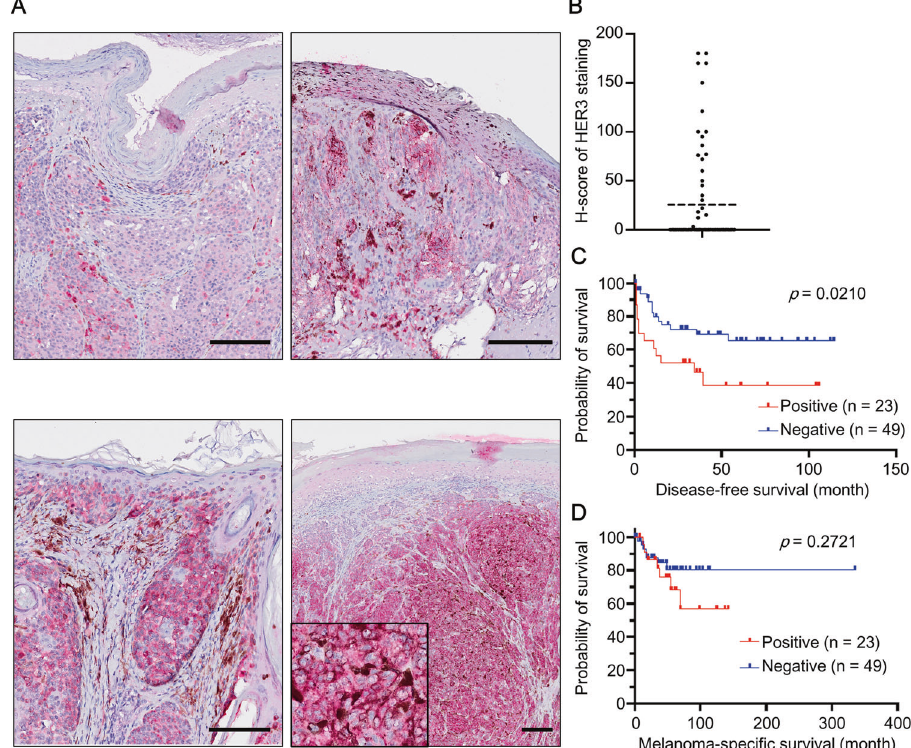
Fig. 1 HER3 expression and relevance of HER3 intensity to the survival of AM patients. A AM tissues from 72 AM patients were immunohistochemically stained for HER3. Representative images are shown. Scale bars = 200 μ m. B HER3 expression in clinical AM tissues was quanti fi ed using a semi-quantitative method and is shown as H-score. The H-score was obtained by multiplying the staining intensity (range 0 – 3 + ) by the percentage of HER3-positive cells. C , D AM patients were categorized into two groups: HER3-negative ( n = 49) and HER3-positive ( n = 23). Survival curves of ( C ) disease-free survival and ( D ) melanoma-speci fi c survival are